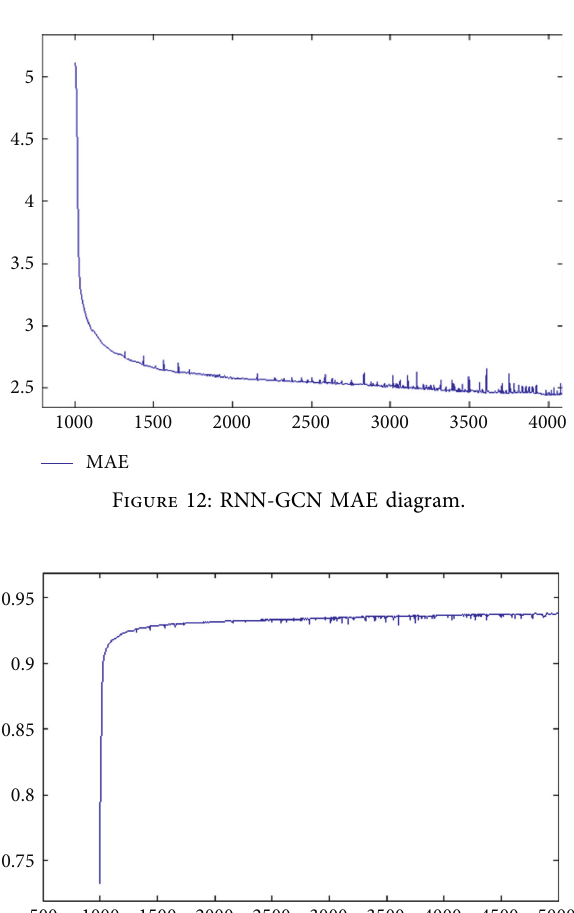
Figure 10: Comparison of traffic speed forecasting experiments.